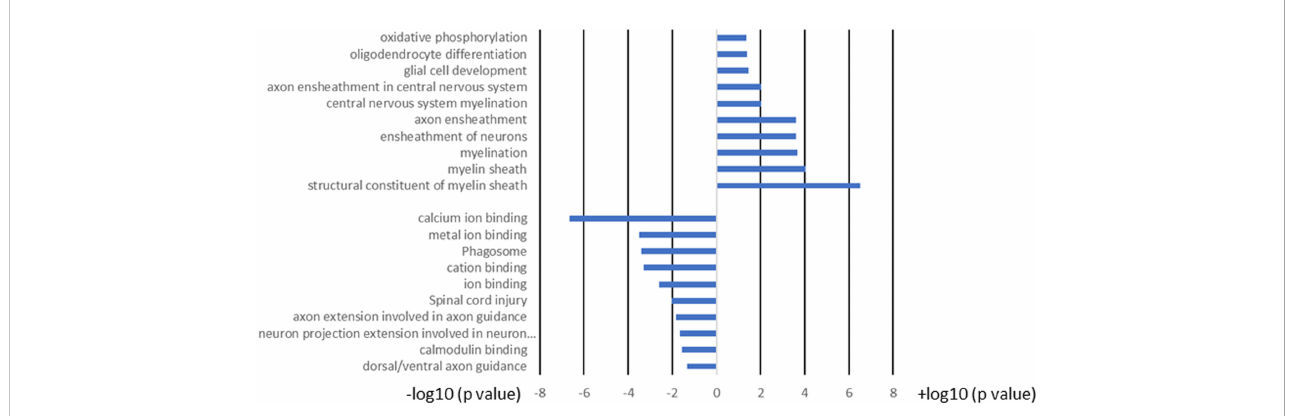
FIGURE 10 GO term analysis of the pathways for the 103 common genes in brain and spinal cord of T cell recipient mice with demyelination. Bars represent log- converted p-values and minus log-converted p-values for upregulated and downregulated genes, respectively, showing statistical signi fi cance for 60 genes that were upregulated and 43 genes that were downregulated in T cell recipient mice with CNS demyelination. The GO terms were ranked according to statistical signi fi cance and the top GO terms for the 60 upregulated genes and the top GO terms for the 43 downregulated genes pathways are shown. Data are based on three independent replicates.